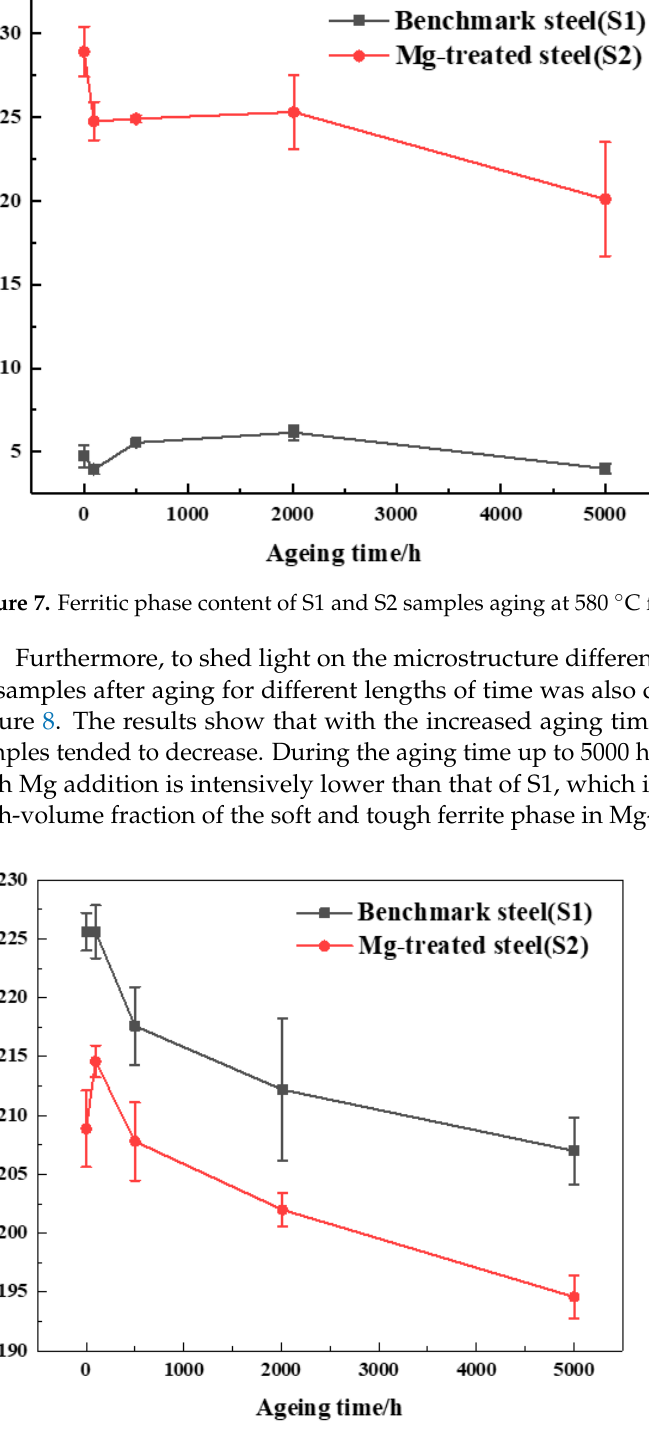
Figure 8. Hardness of S1 and S2 samples aging at 580 °C for different lengths of time.